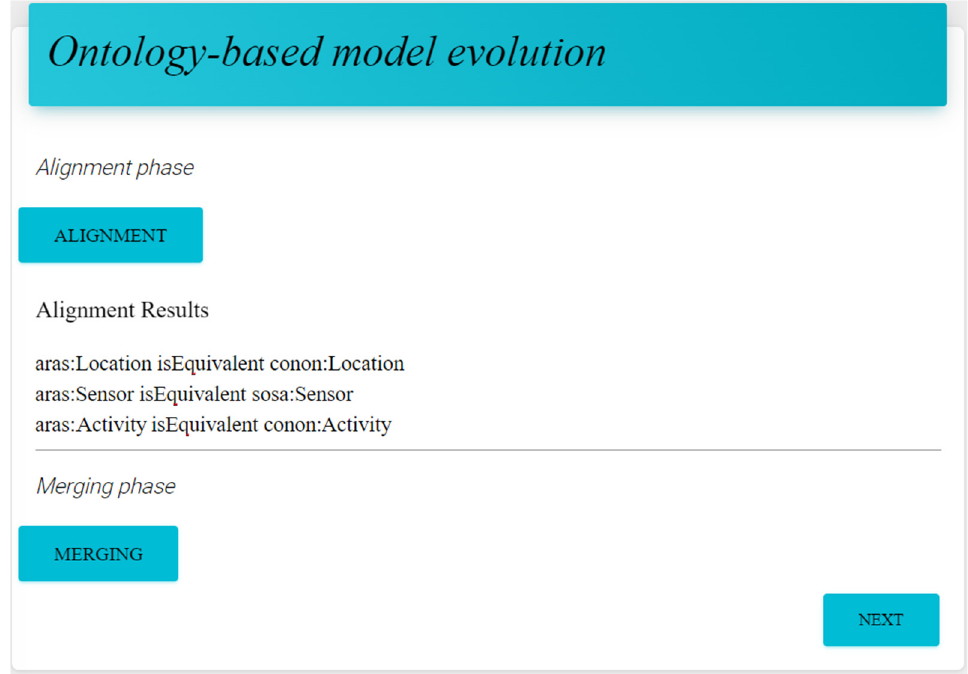
Figure 22. Ontology-based model evolution at t 2 in the alignment phase, an example of the main alignment findings.